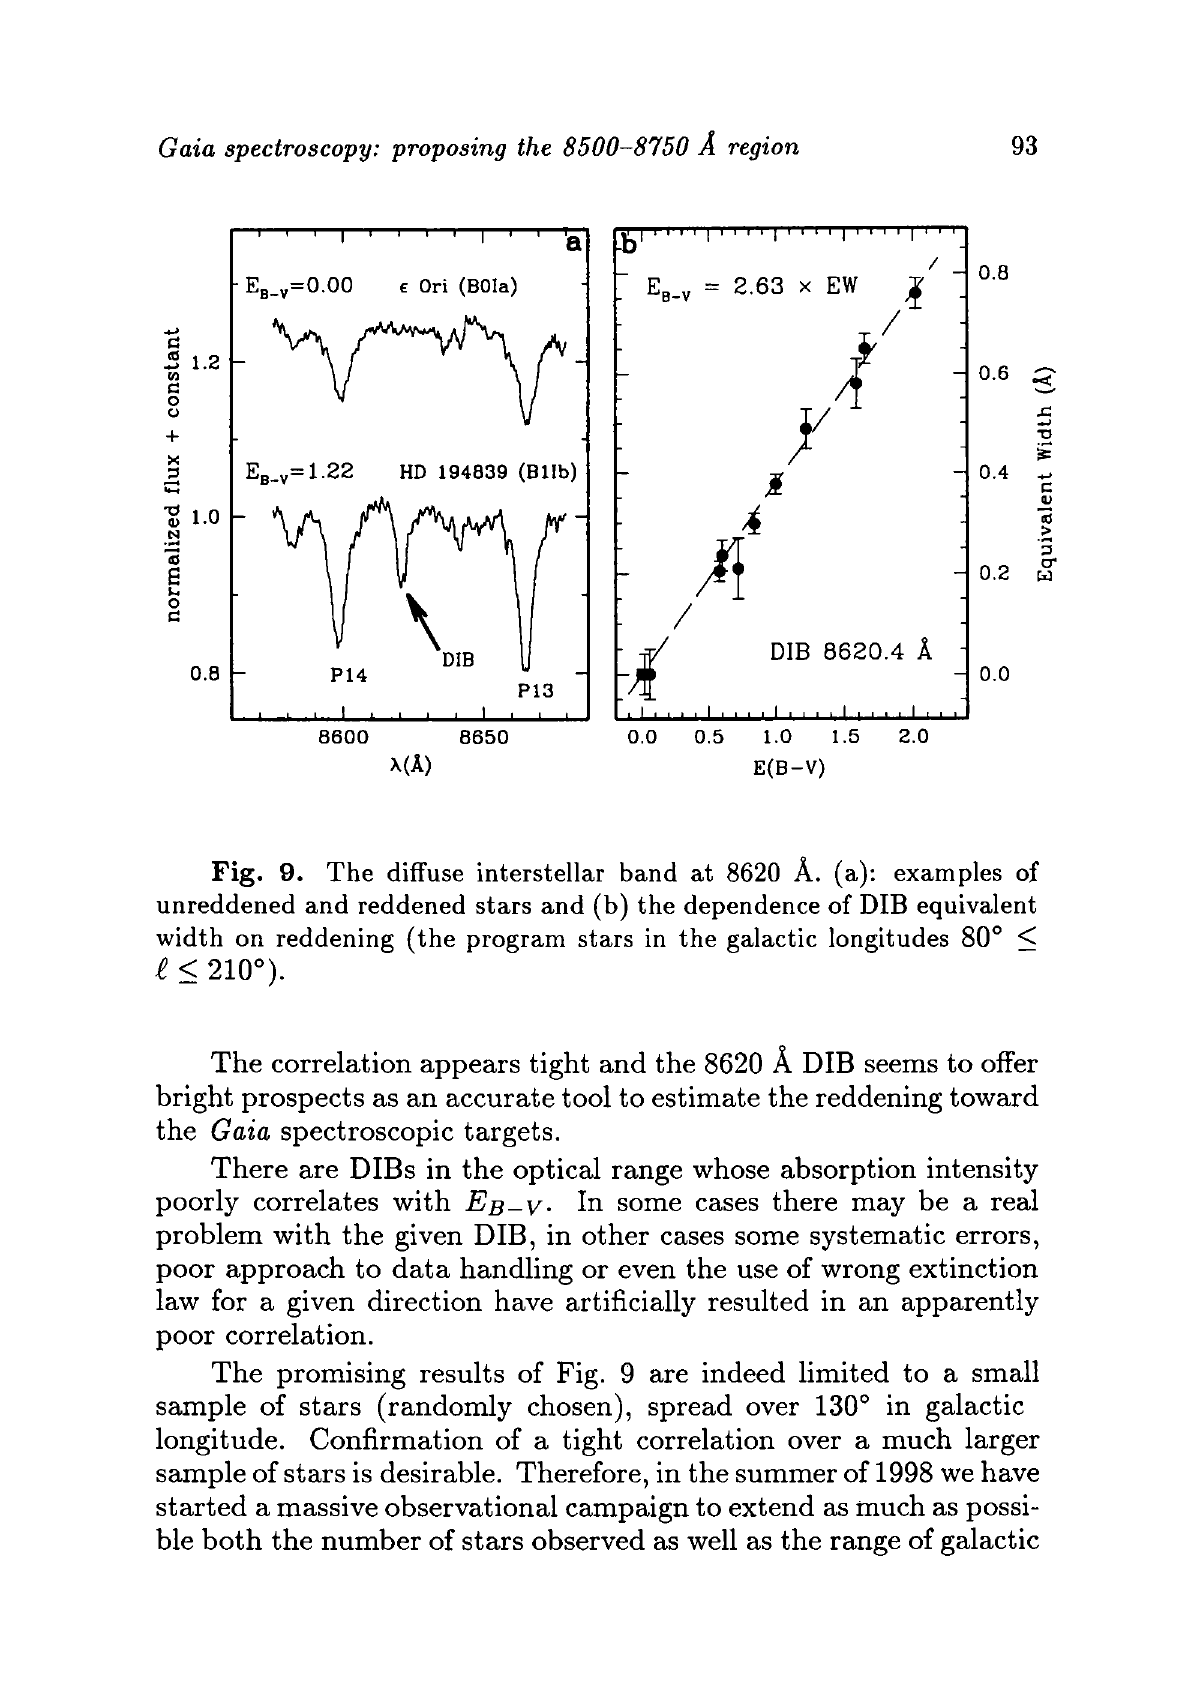
Fig. 9. The diffuse interstellar band at 8620 Â. (a): examples of unreddened and reddened stars and (b) the dependence of DIB equivalent width on reddening (the program stars in the galactic longitudes 80° < i <